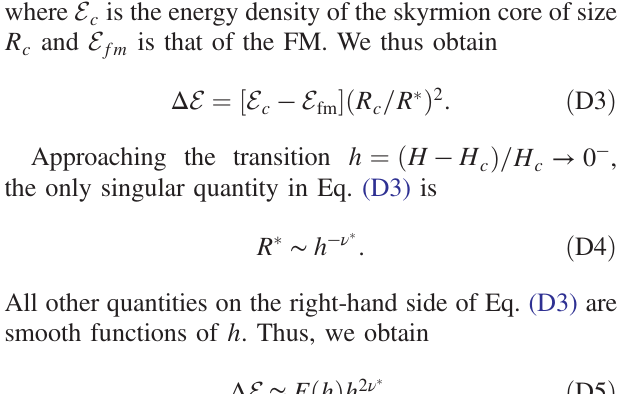
FIG. 5. Skyrmion length scales . We show plots of the H dependence of the optimal skyrmion cell radius R (cid:3) and the core radii defined by the location of the maxima of j dm z =dr j . For the ansatz of Eq. (5) in the text, dm z =dr ¼ j 2 π r χ ð r Þj . (a) In the easy- axis region, both R (cid:3) and the core radius R c are finite at the spiral- to-SkX phase boundary, but R (cid:3) diverges while R c remains finite at the SkX-to-FM transition. The vertical dashed lines indicate phase transitions from the SkX to the spiral state (at small H ) and to the FM (at large H ). (b) In the easy-plane region, there are two core radii corresponding to the two maxima in j 2 π r χ ð r Þj . These inner and outer core radii R c 1 and R c 2 , and the cell radius R (cid:3) all remain finite at the two phase transitions out of the SkX phase. Here, the vertical dashed lines indicate SkX-FM